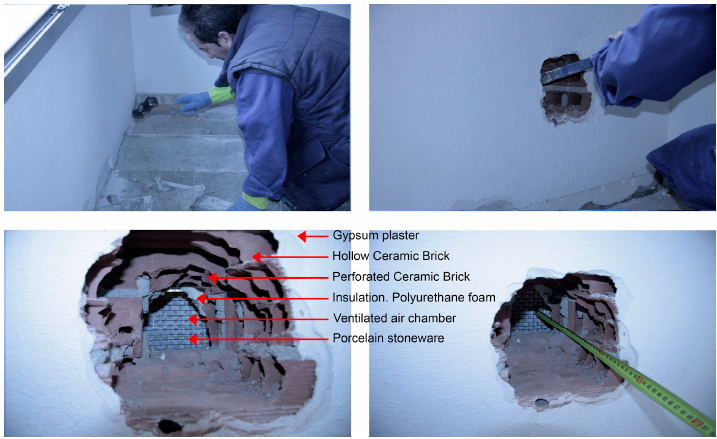
Figure 9. Destruction process of the enclosure to introduce the sensors.